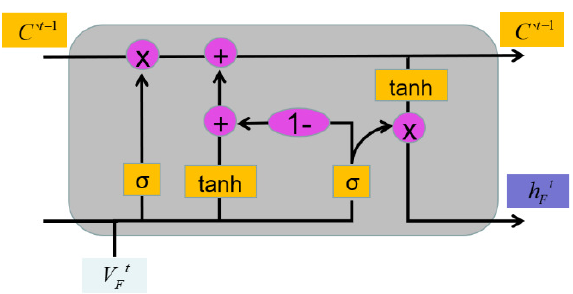
Figure 5. Structure of the GRU neuron unit.